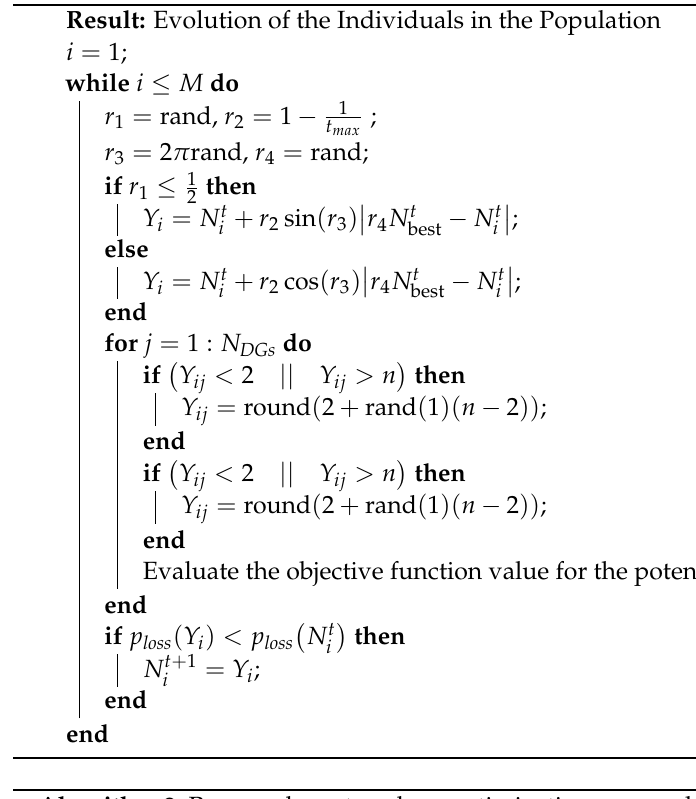
Algorithm 2: Proposed master–slave optimization approach. Result: Optimal location and sizing of